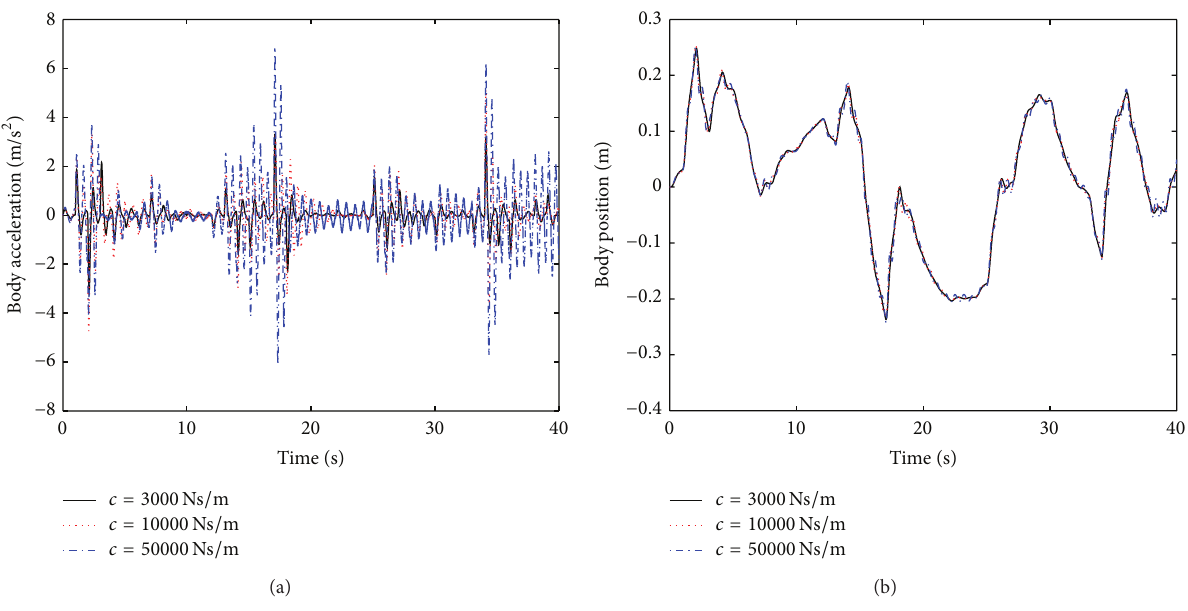
Figure 10: Acceleration and displacement of the sprung mass with different suspension damping